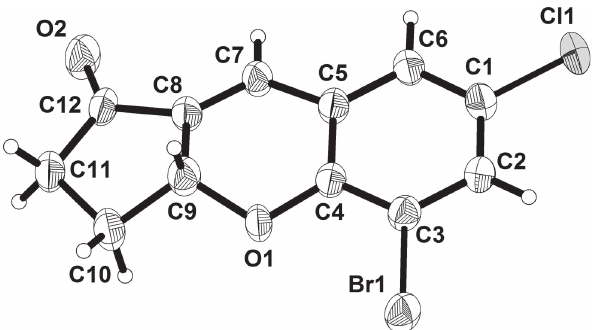
Table 1: Data collection and handling.